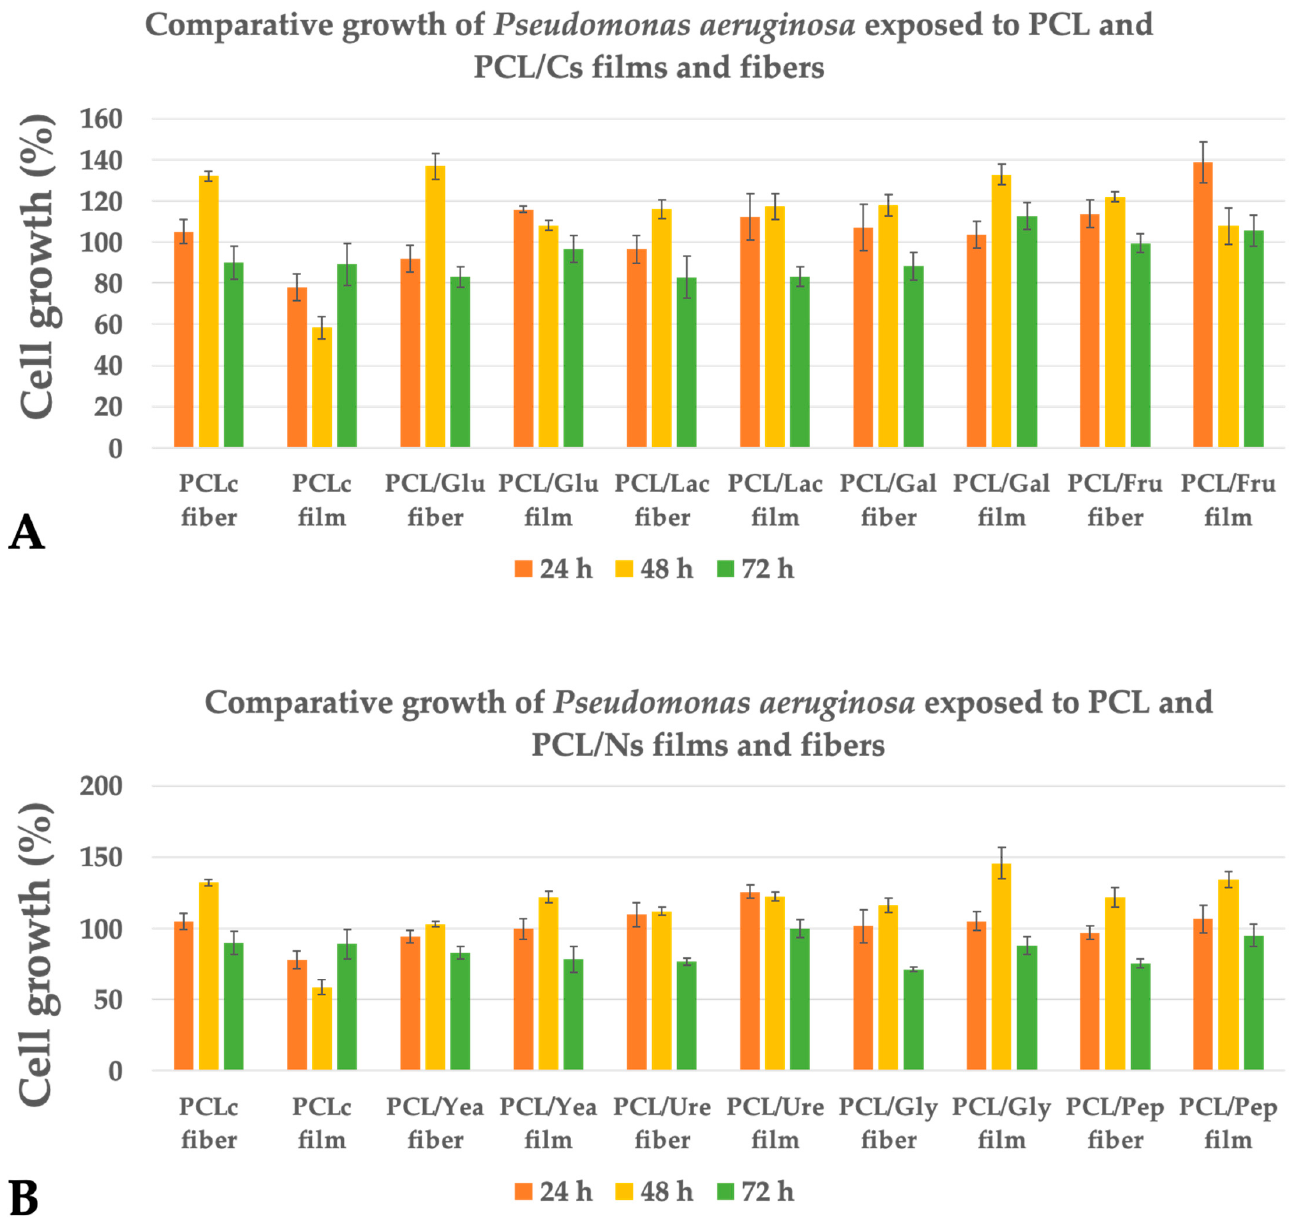
Figure 5. Comparative growth of Pseudomonas aeruginosa exposed to (A) PCL/Cs and (B) PCL/Ns for fibers and films.